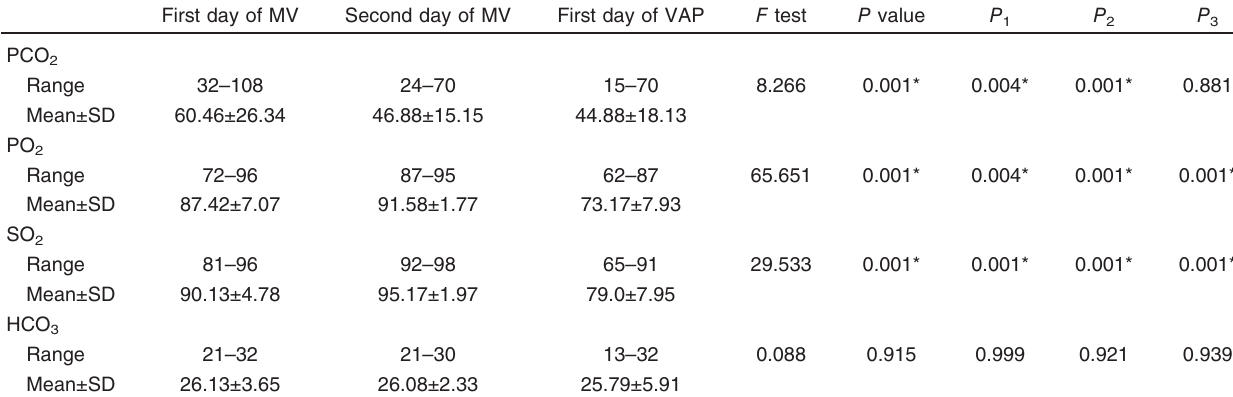
Table 5 Arterial blood gas analysis on the first day of mechanical ventilation, the second day of mechanical ventilation, and on the first day of ventilator-associated